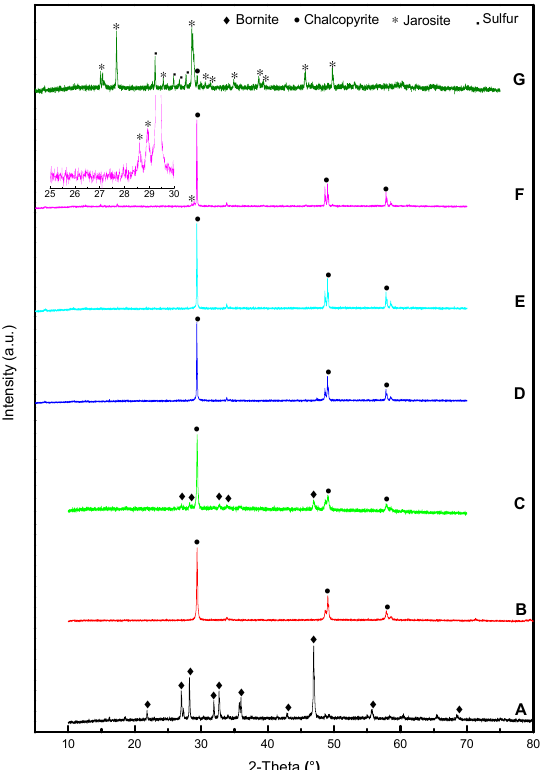
Figure 2. X-ray diffraction (XRD) patterns of co-bioleaching chalcopyrite and bornite (ratio of Ccp/Bn was 3:1). ( A ) bornite, ( B ) chalcopyrite, ( C ) Ccp/Bn = 3:1, ( D ) 5 days, ( E ) 10 days, ( F ) 15 days, ( G ) 30 days.